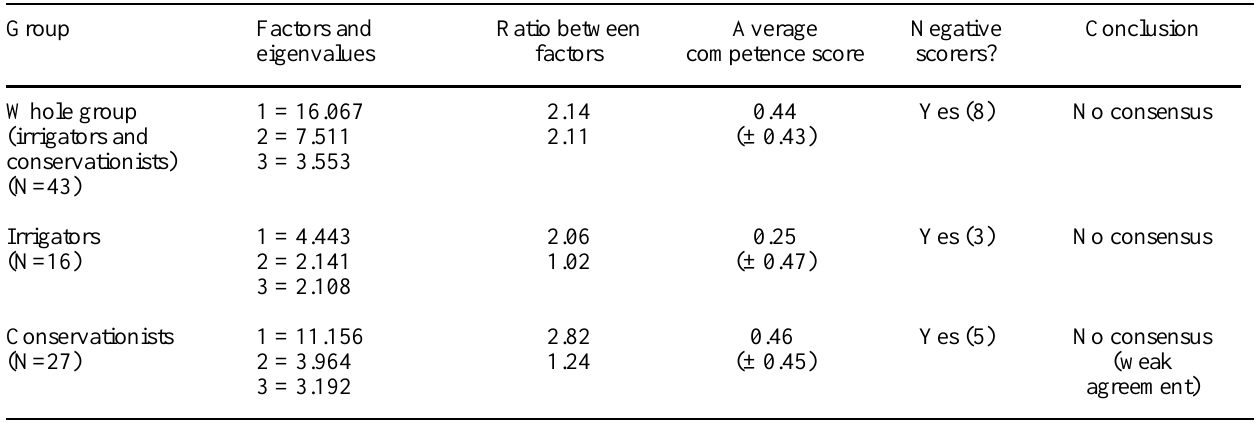
Table 5 . Results of the consensus analysis of the yes/no questionnaire “causes of the problems with current flows in the Crocodile River?” (31 items). Group Factors and Ratio between eigenvalues